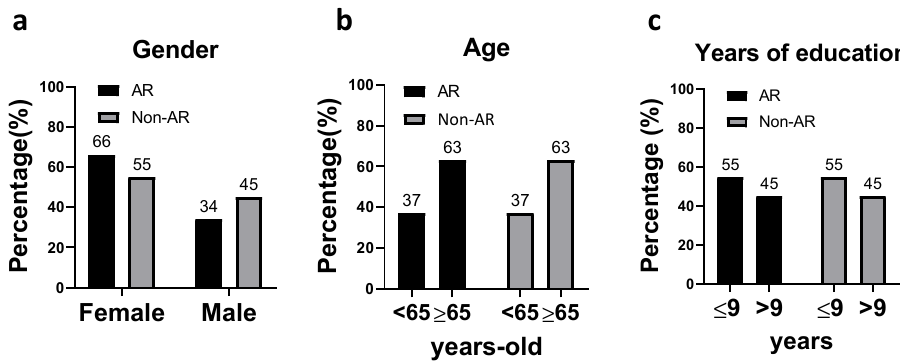
Figure 2. Distribution of the demographic characteristics in the study population: ( a ) gender, ( b ) age, and ( c ) years of education.